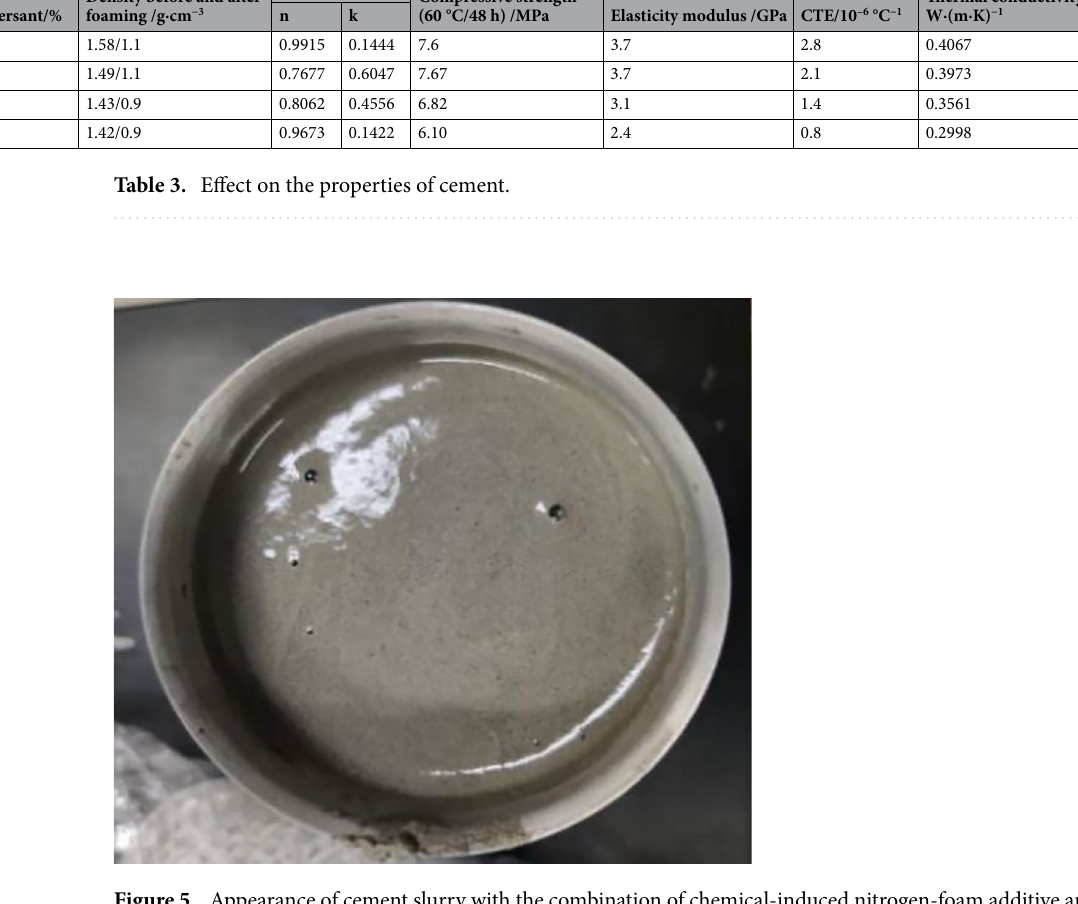
Figure 5. Appearance of cement slurry with the combination of chemical-induced nitrogen-foam additive and glass